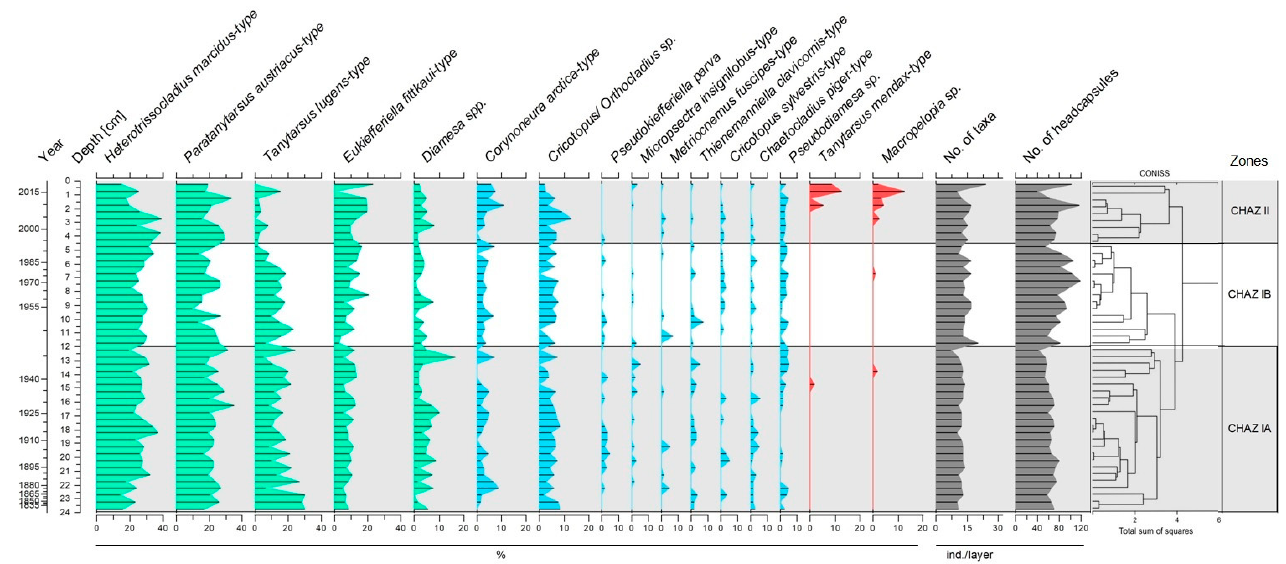
Figure 3. Relative abundances of the most common chironomid taxa (>5%), values of the taxonomic richness, and head capsule counts in the VRP sediment sequence. Colours denote: ■ taxa with rel- ative abundance >10%, ■ taxa with relative abundance 5–10%, ■ thermophilic taxa, ■ number of taxa and number of head capsules.